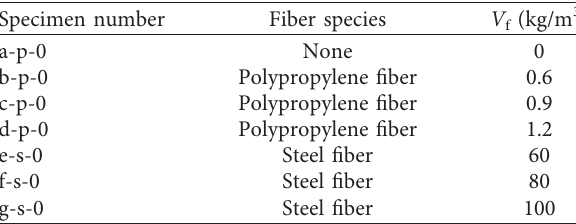
Table 3: Test conditions of prism specimens.